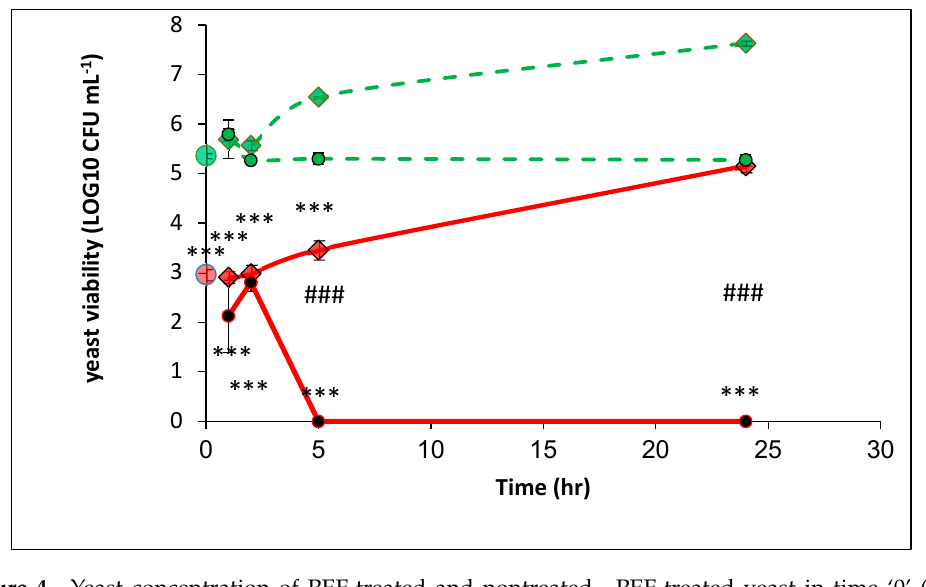
Figure 4. Yeast concentration of PEF-treated and nontreated. PEF-treated yeast in time ‘0’ ( ); nontreated yeast in time ‘0’ (